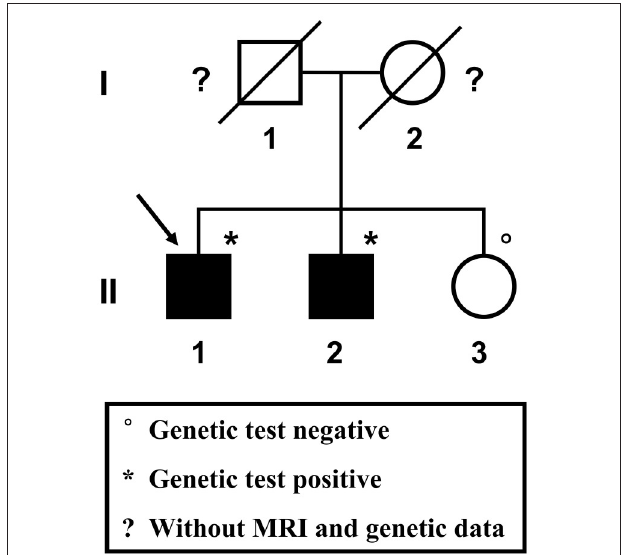
FIGURE 1 | Pedigree of the studied Chinese family. The proband is indicated by the arrow. Squares represent males; circles represent females. Black-filled symbols indicate a member showing multiple cerebral cavernous malformations upon SWI-MRI of the brain. A diagonal line through the symbol represents a deceased